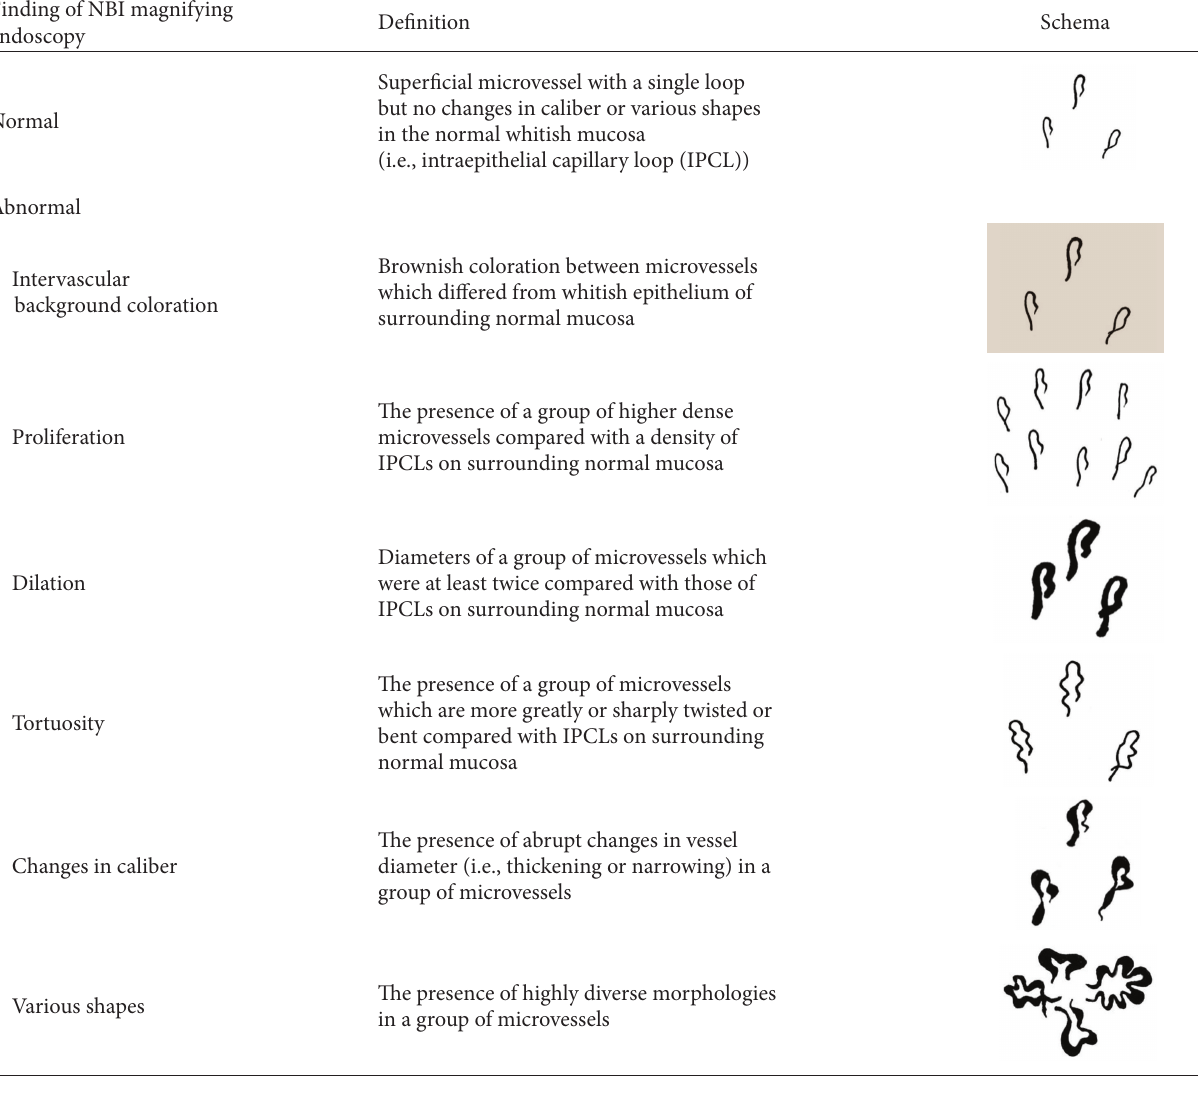
Table 1: Definitions and schemas of normal and abnormal microvessels.